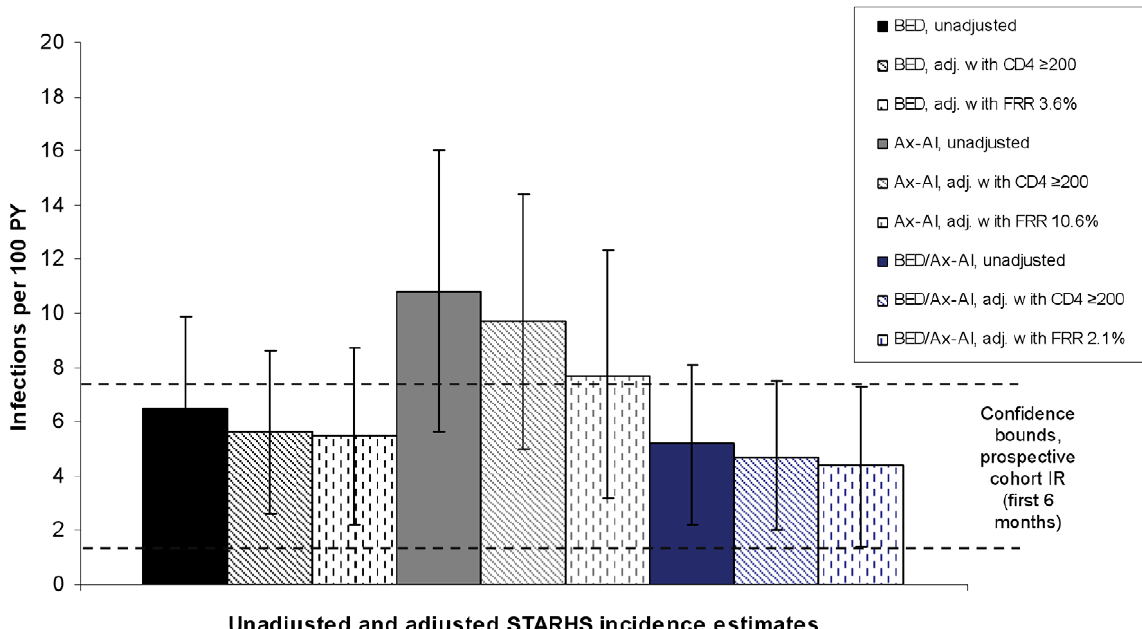
Figure 3. STARHS assay-based incidence estimates, cross-sectional sample. doi:10.1371/journal.pone.0018402.g003 PLoS ONE |